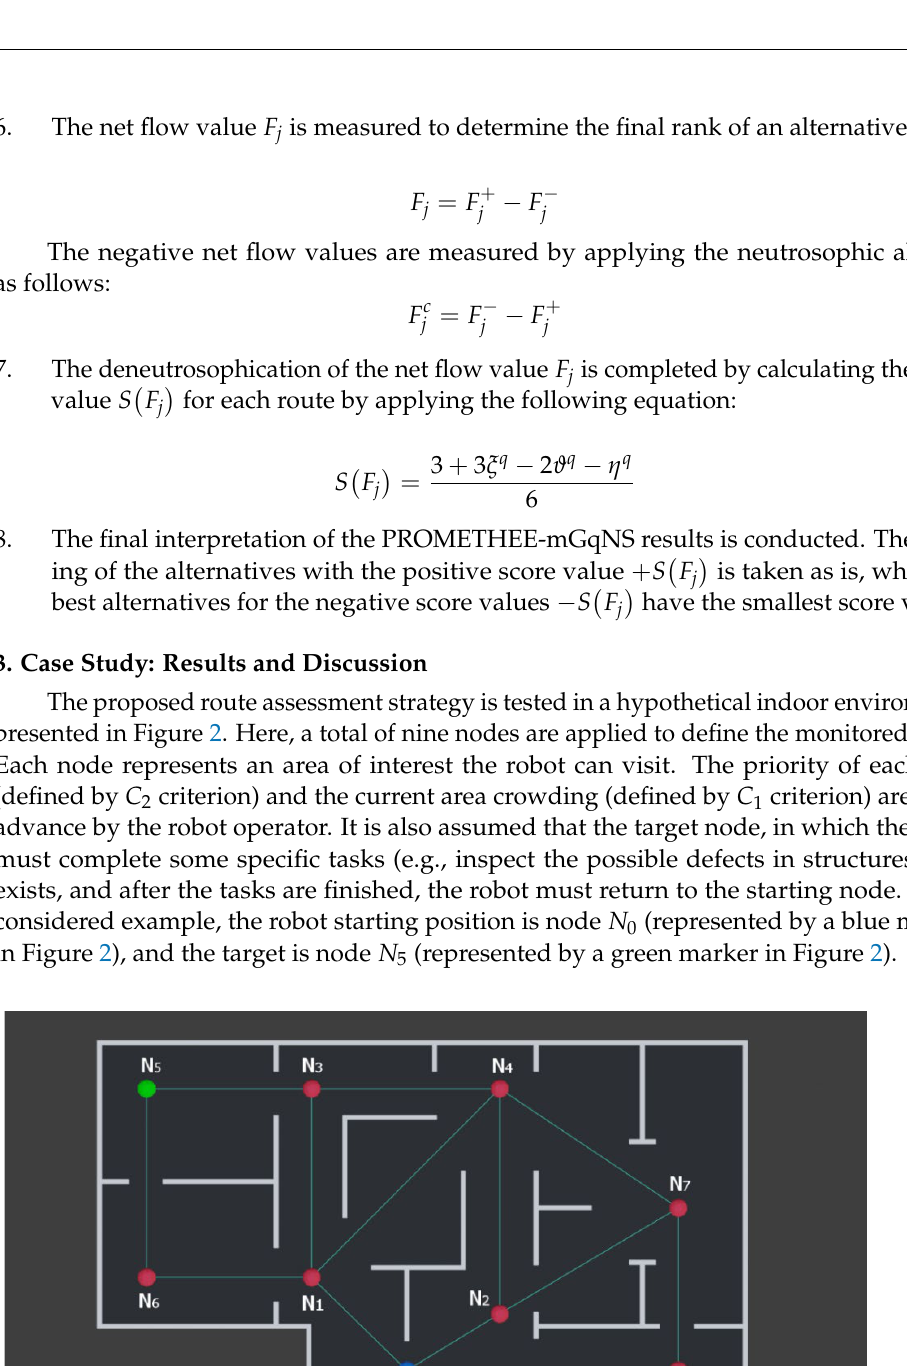
Figure 2. Example of the monitored environment. The robot starts at the blue node, marked as N 0 . The target node is green, marked as N 5